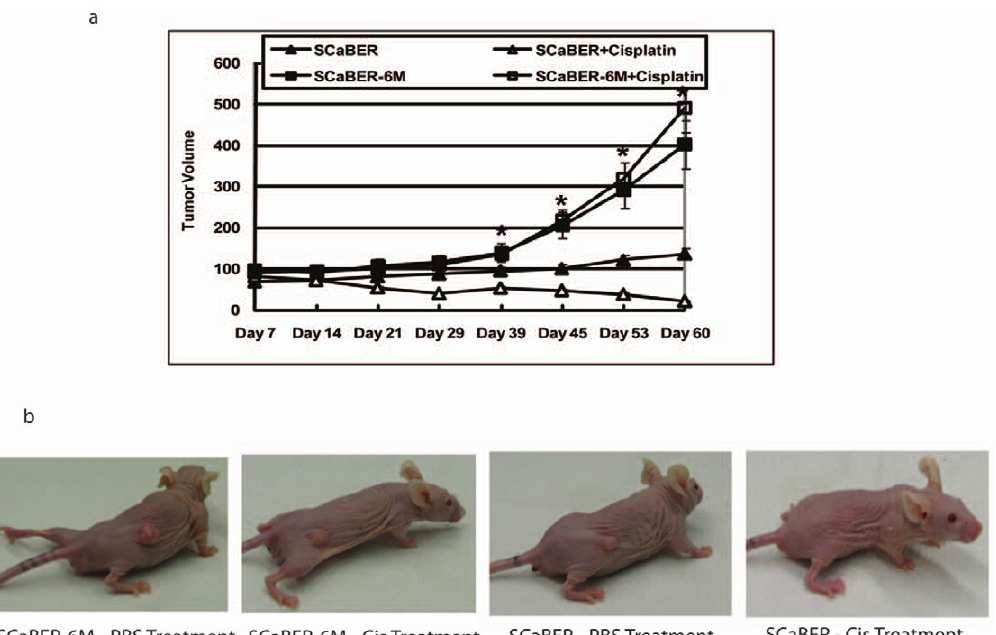
Figure 7. CSC Vapor Induces Cisplatin Resistance In Xenograft Model. (a) Subcutaneous xenografts were generated in of 5- to 6-week-old female athymic nu/nu mice with SCaBER or SCaBER-6M cells. One week following tumor cell inoculation, mice were treated with either PBS or cisplatin (3 mg/Kg/dose). The mean tumor volume was calculated. * indicates P , 0.01 (b) One representative mouse from each group was displayed.